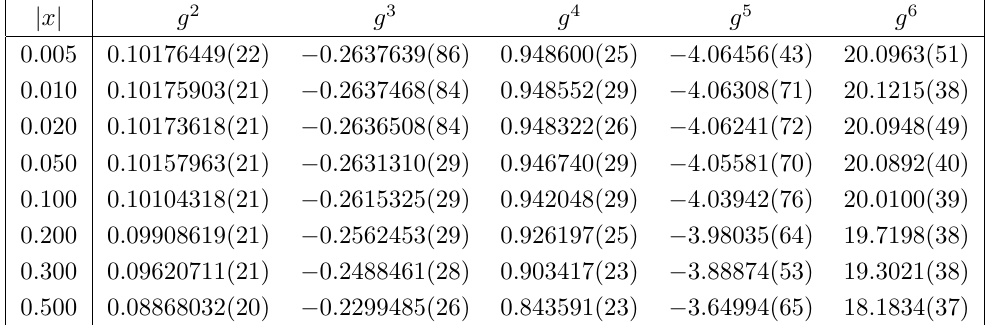
Table 9 . Series coe(cid:14)cients for the two point function h (cid:30) ( x ) (cid:30) (0) i up to order g 6 for some selected values of x . We omit here the tree level term-given by G 0 ( x ) de(cid:12)ned in eq. (3.2) | and the O ( g ) term which is identically zero in the chosen